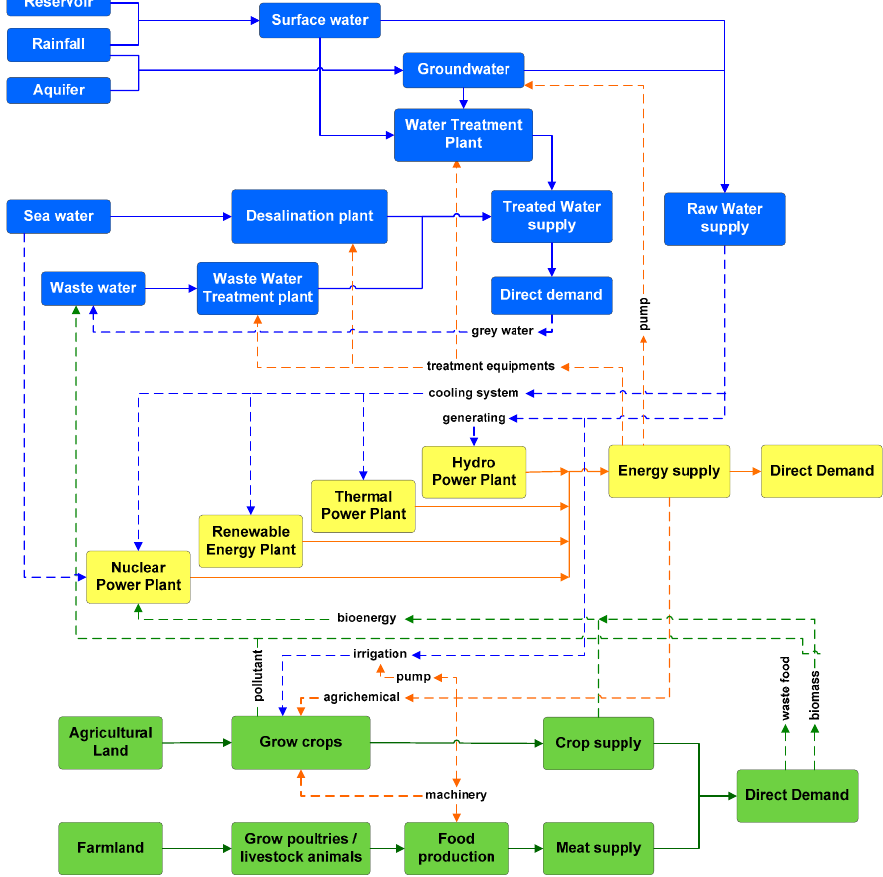
Figure 1. The conceptual framework of the water–energy–food (WEF) nexus simulation model